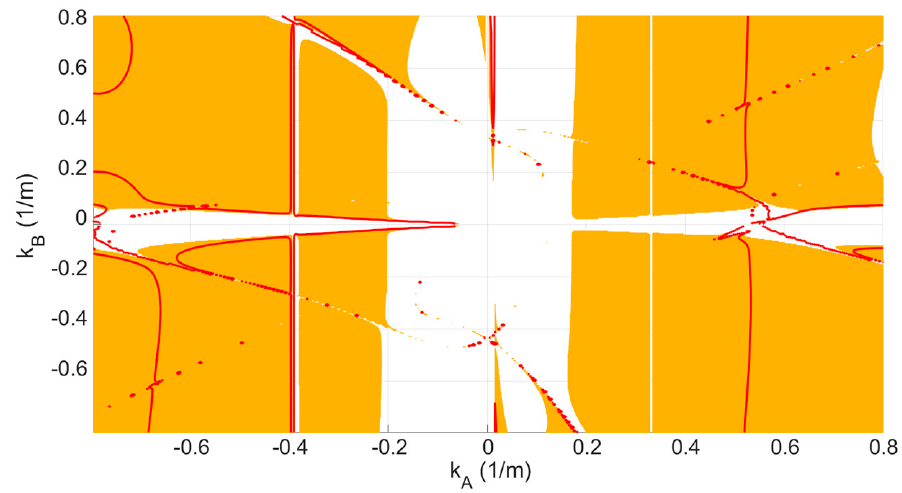
Figure 7. The region where −2 ≤ 𝐹 (cid:2869) ≤ 2 when 𝑈 (cid:3040) = 0.5 ( m/s ) . The red lines indicate where 𝐹 (cid:2869) = 0 .